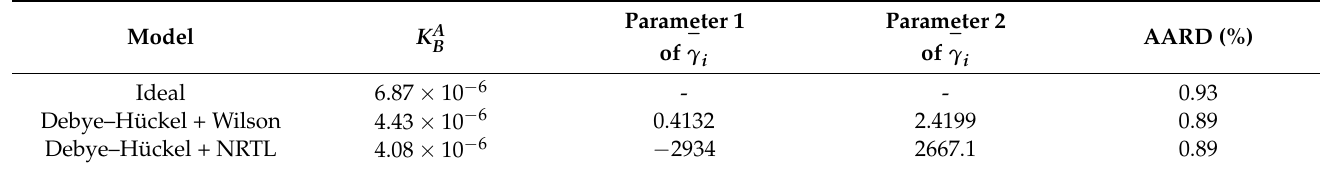
Table 2. Equilibrium parameters obtained for the Hg 2+ /Na + /ETS-4 system. The range of ionic strength ( I ) in the liquid solution is ( 6.74 − 6.83 ) × 10 − 4